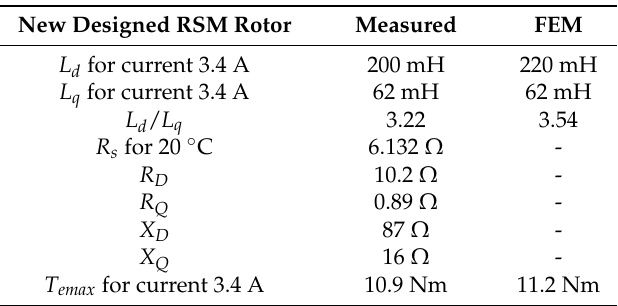
Table 1. Measured and calculated parameters.